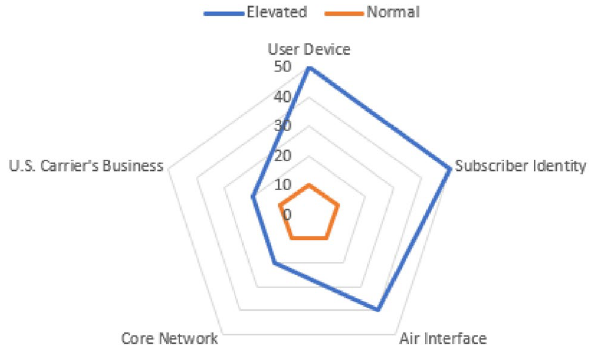
Fig. 6 Spoofed WEA message risk rating Fig. 7 SS7/diameter risk